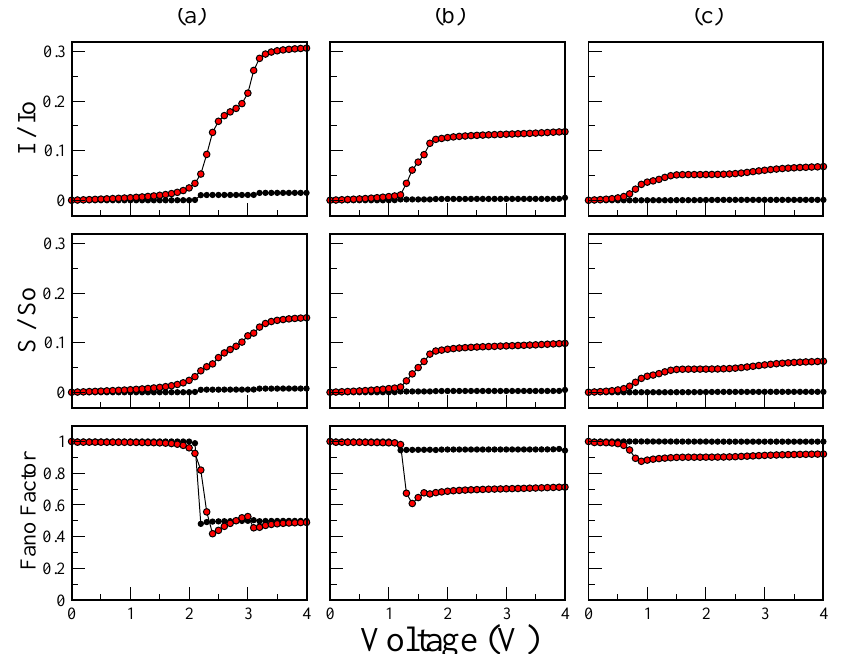
Figure 6. (color online) I − V characteristic ( I / I o ), shot noise ( S / S o ), and Fano factor as a function of bias voltage for the molecular system with ( a ) one thiophene ring; ( b ) two thiophene rings; and ( c ) three thiophene rings. Calculations are for E c = − 5.54 eV, E s = 0.98 eV, t d = t δ = t c = − 2.40 eV, t τ = t s = − 0.83 eV values and (Black dots) Γ = 0.1 eV, and (red dots) Γ = 5.32